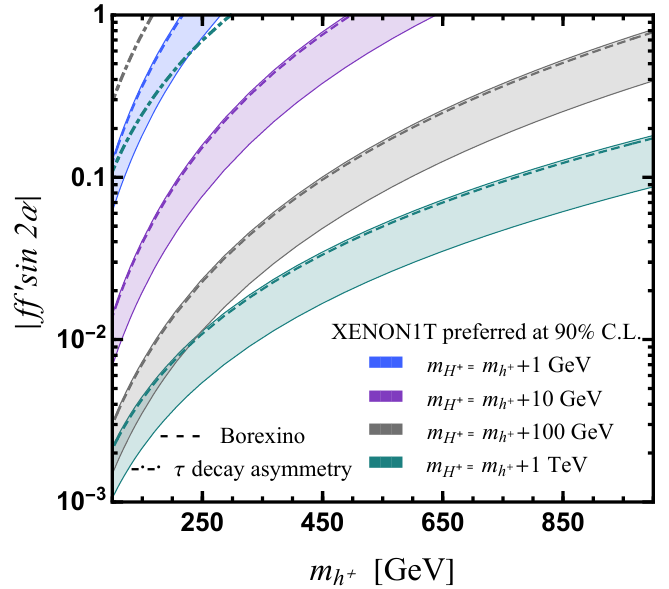
Figure 3 . Allowed parameter space in j ff 0 sin 2 (cid:11) j(cid:0) m + plane to explain XENON1T electron recoil h excess. Blue, purple, gray and green color correspond to di(cid:11)erent mass choices m = m + 1 H + h + GeV, m = m + 10 GeV, m = m + 100 GeV and m = m + 1 TeV respectively. H + h + H + h + H + h + The dashed lines indicate the present BOREXINO limit on neutrino magnetic moment and the dot-dashed lines denote the exclusion lines from (cid:28) decay